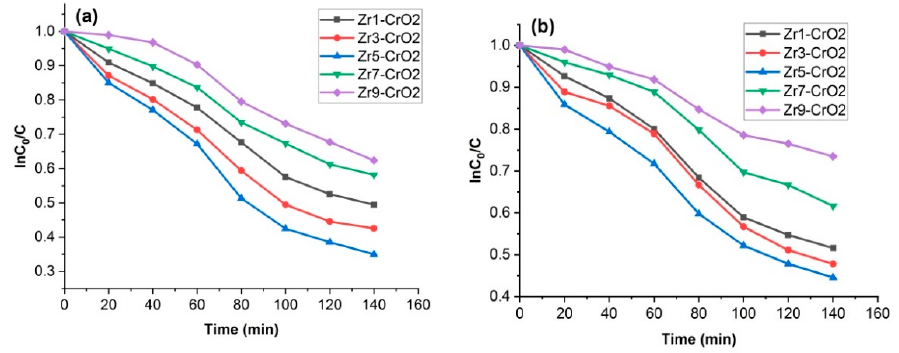
Figure 9. Photocatalytic degradation curve of ( a ) Methylene blue ( b ) Methyl orange.